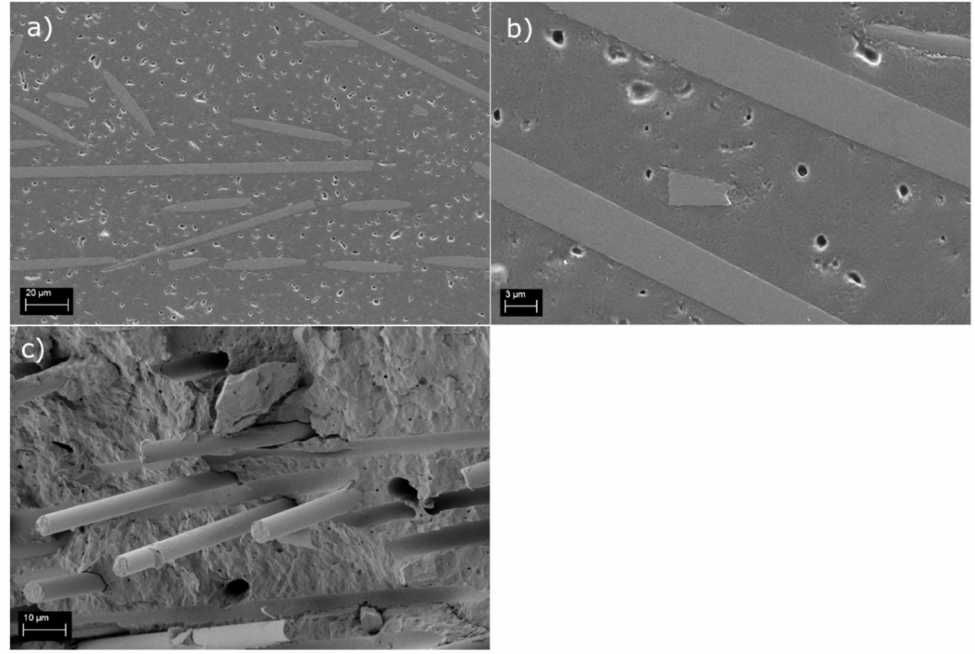
Figure 7. Polished cross-section ( a , b ) and fracture surface ( c ) of the PP rCFs